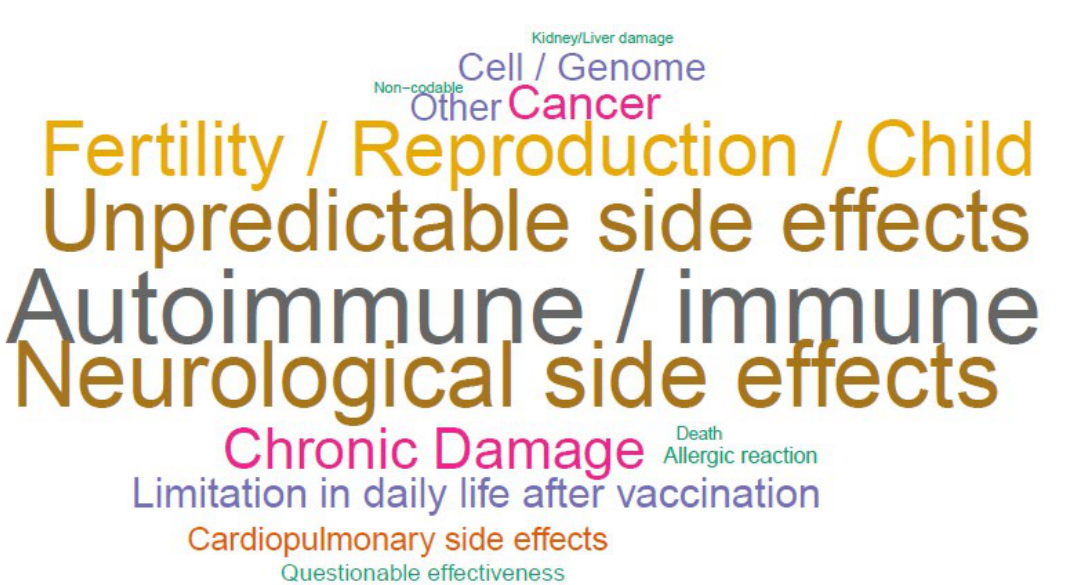
Figure 6. Word cloud of feared long-term side effects, constructed from upper categories.